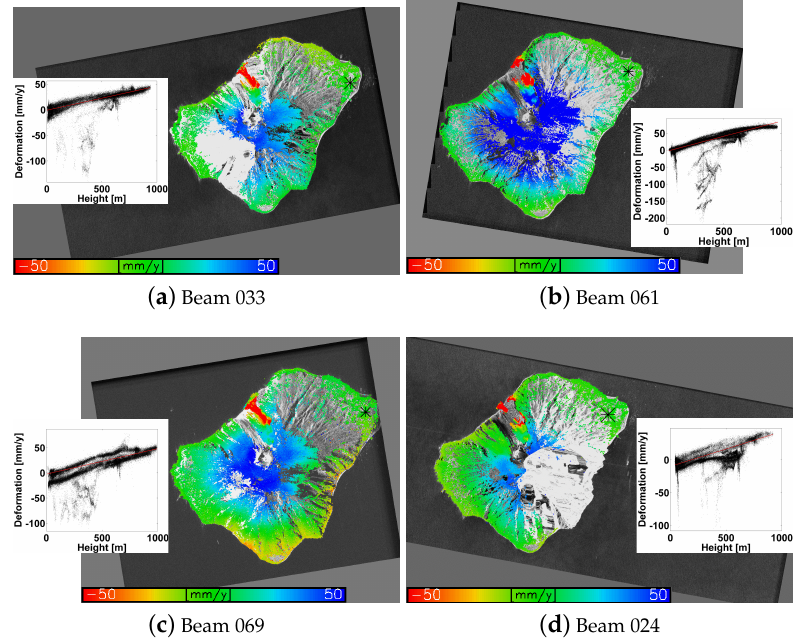
Figure 7. PS deformation maps without tropospheric correction of four TerraSAR-X HRSL stacks over the Stromboli Island with the geocoded average amplitude image as background. These stacks cover the time period January to October 2008 and contain ( a ) 18, ( b ) 17, ( c ) 16 and ( d ) 17 acquisitions. A scatter plot of deformation versus height is also illustrated for each of them. A linear fit is presented as a red line on each scatter plot. A clear correlation between deformation estimates and height is